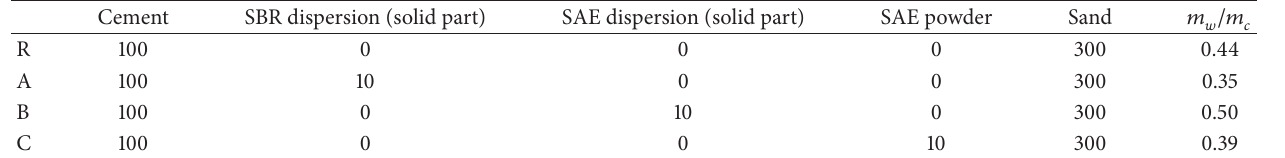
Table 3: Mix proportions of mortar in weight